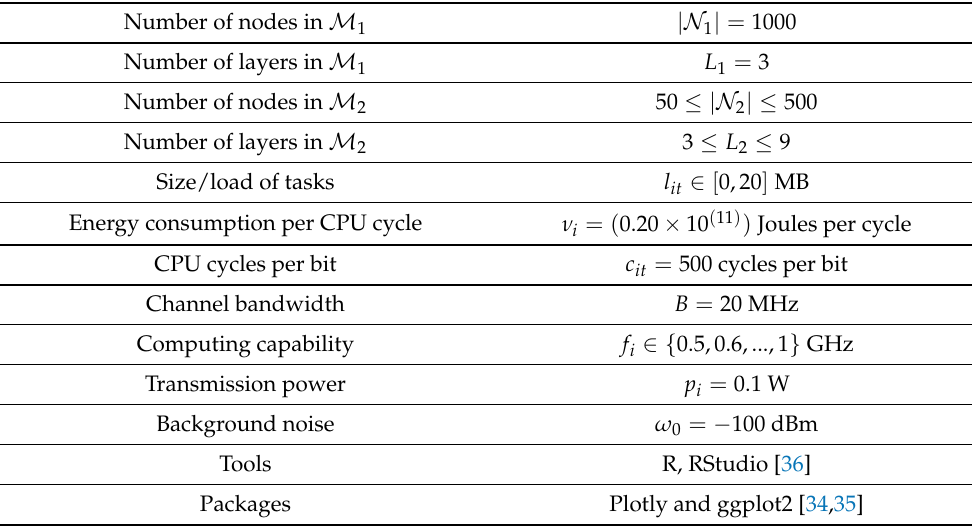
Table 1. Synthesis of simulation conditions, tools and